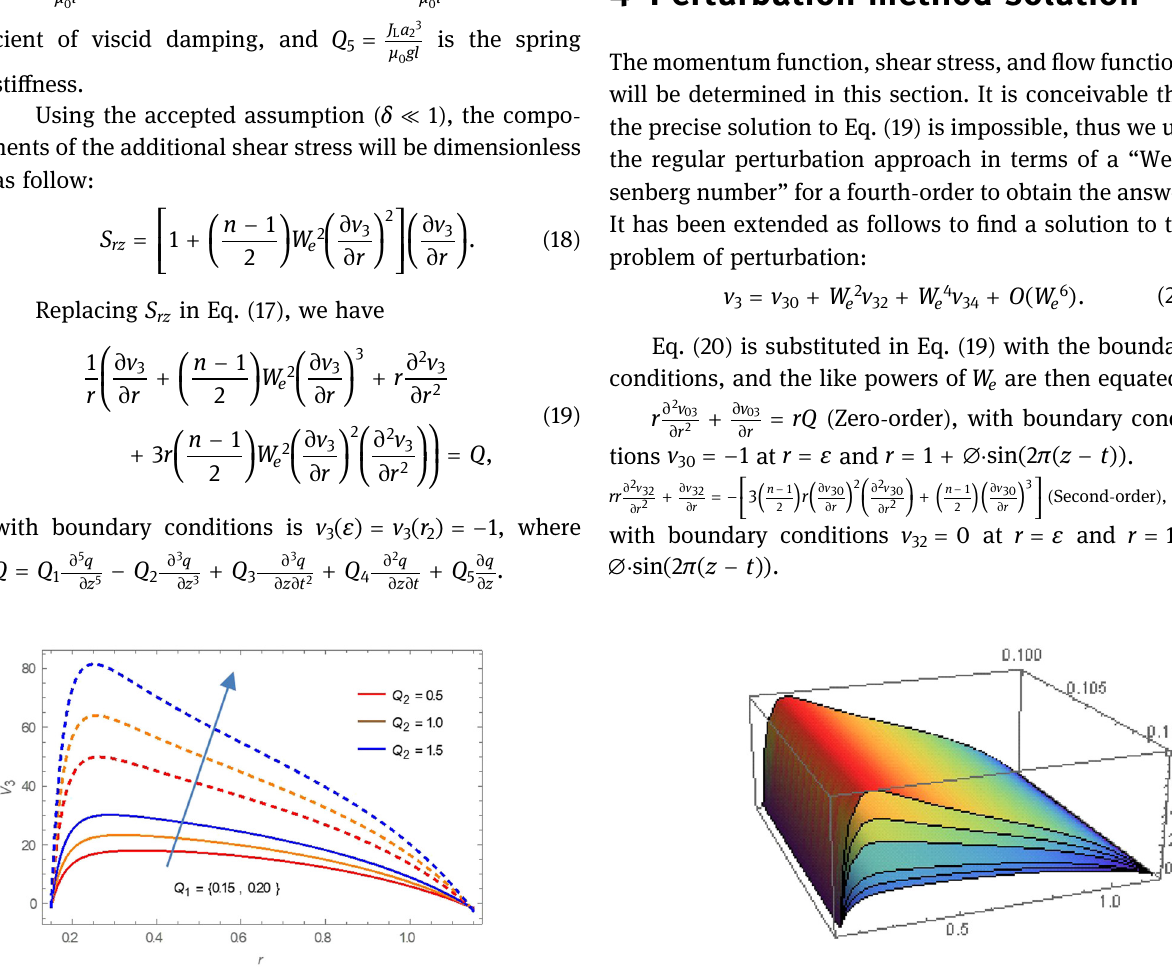
Figure 3: Distribution of velocity for di ff erent values of Q 1 and Q 2 with